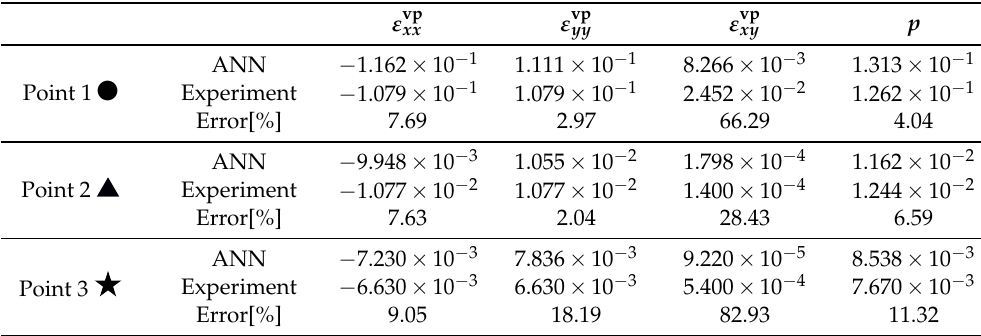
Table 8. Comparison between the ANN model and the (virtual) experimental values at the end of the butterfly test for selected points: strain comparison